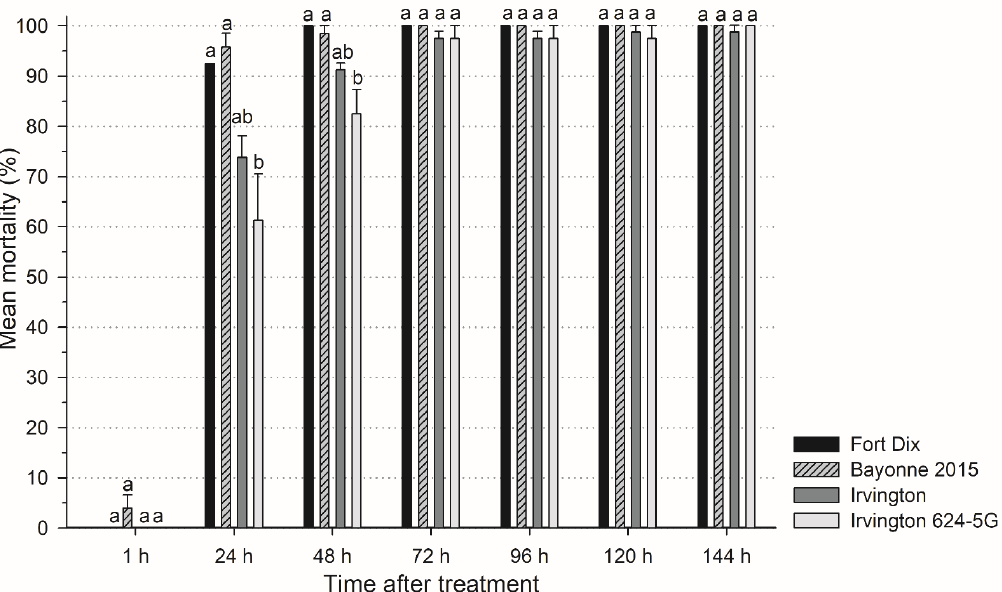
Figure 1. Mean mortality (%) of laboratory C. lectularius and three field-collected C. lectularius populations exposed to CimeXa insecticide for 5 min on unpainted wood panel. For each observation period, the mean mortality with same letter within same time means no significant difference among populations (ANOVA, p > 0.05). Control groups had no mortality.